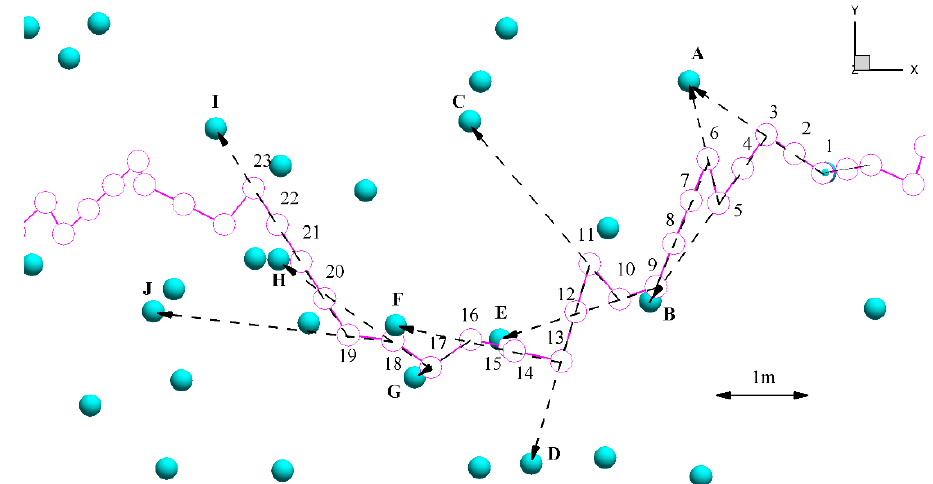
Figure 4. Movement path of a fish using the modified algorithm. Numbers (pink circles) #1–#23 are indicators of fish positions. Letters A–J (light blue spheres) indicate nodes of the computational mesh. Dashed arrows indicate the direction of movement, and point towards the computational node used to calculate fluid, ground and swimming velocity.